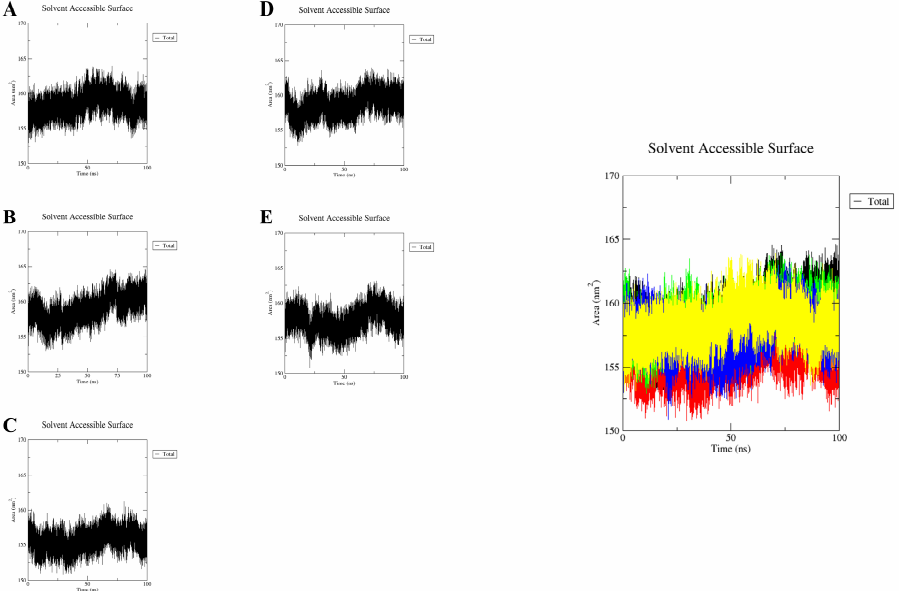
Figure 10. Estimation of SASA values of resveratrol ( A ); bisphenol A ( B ); 17 β -estradiol ( C ); G-1 ( D ); G-15 ( E ). Estimation of SASA values of resveratrol (yellow); bisphenol A (black); estradiol (red); G-1 (green); G-15 (blue).